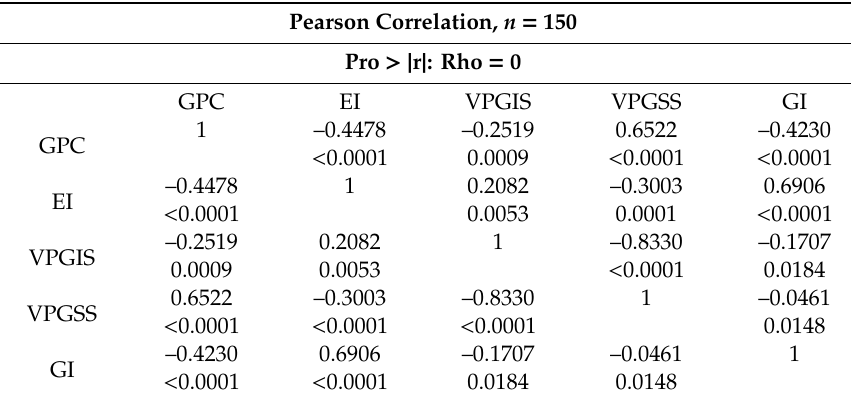
Table 3. Pearson correlation for variables before SFA.